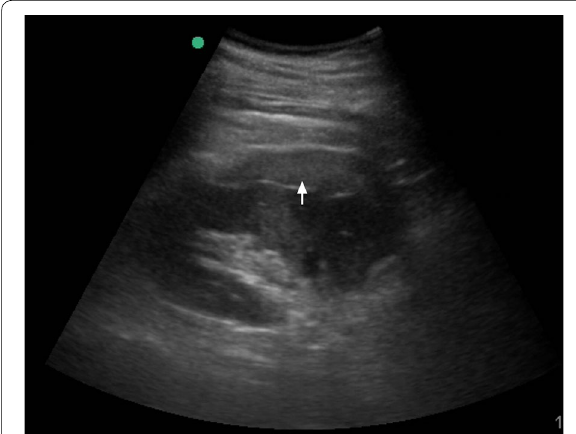
Fig. 1 Point-of-care Ultrasound of the right kidney. Sixty-one-year-old male 24 h after ESLW presenting with acute right lumbar pain. Point-of-care ultrasound: longitudinal view of the right kidney using a 5-MHz curvilinear probe showing a subcapsular hyperechogenic collection of fluid, corresponding to an acute subcapsular renal hematoma (arrow)